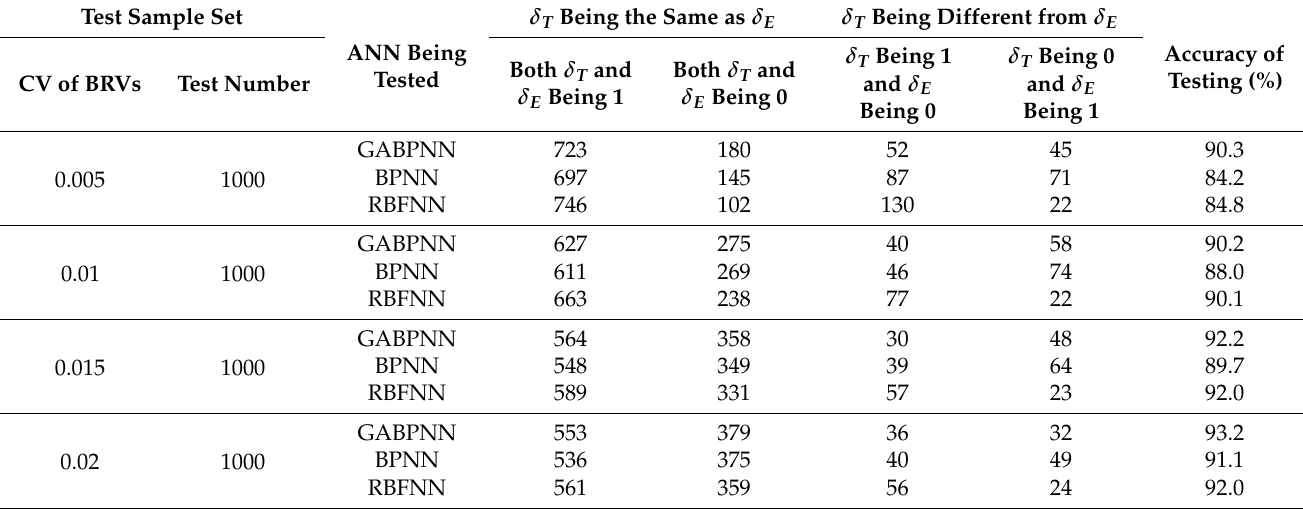
Table 5. The comparison of the test results of the ANNs in the IP study under the shock load condition where v is 1050